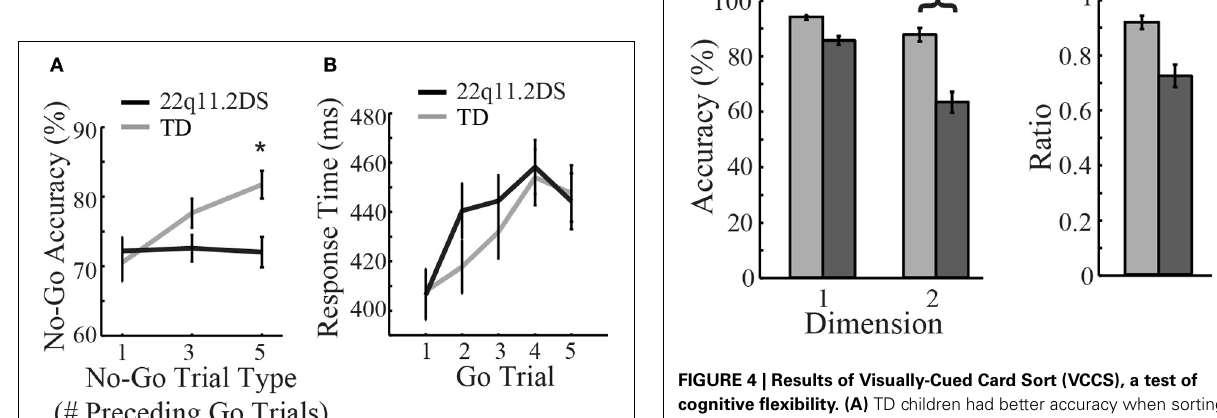
FIGURE 4 | Results of Visually-Cued Card Sort (VCCS), a test of cognitive flexibility. (A) TD children had better accuracy when sorting by both dimensions (predominant and secondary, ∗ p < 0 . 05). (B) Children with 22q11.2DS performed significantly worse when sorting by the secondary dimension relative to the predominant dimension, as indicated by this group difference in the ratio score of accuracy on Dimension 2 divided by that of Dimension 1 ( ∗ p < 0 .